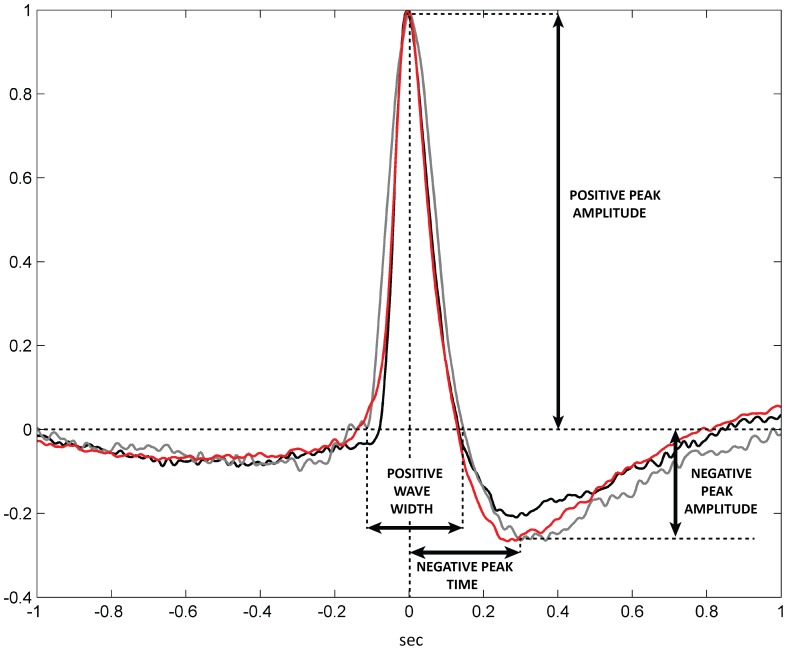
Group-averaged EOG blinks.In the present figure, group-averaged EOG blinks are presented. The red trace refers to CTRL subjects, the gray trace to MCS and the black one to VS/UWS. For each subject the mean blink was normalized to its maximum amplitude. Group-averages were obtained mediating among subjects of the group. In the figure the four features chosen to describe the blink morphology are presented for illustrative purposes (positive peak amplitude, positive wave width, negative peak amplitude, and negative peak time location). Note that statistics on the presented features were perfomed on raw (non-normalized) blinks.